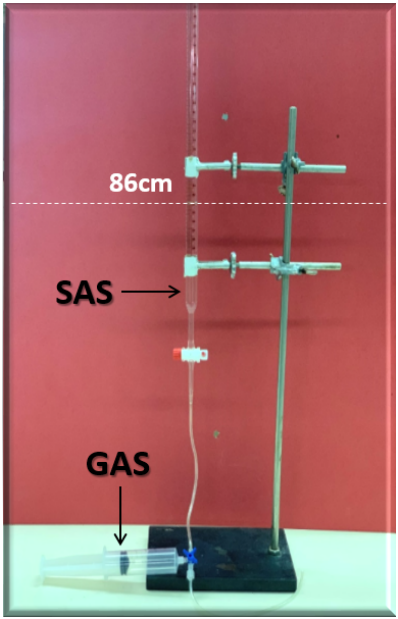
Figure 8. Foamability and foam stability set-up using the R5 parameter, which is defined as the ratio of foam-height at five-minutes to initial foam